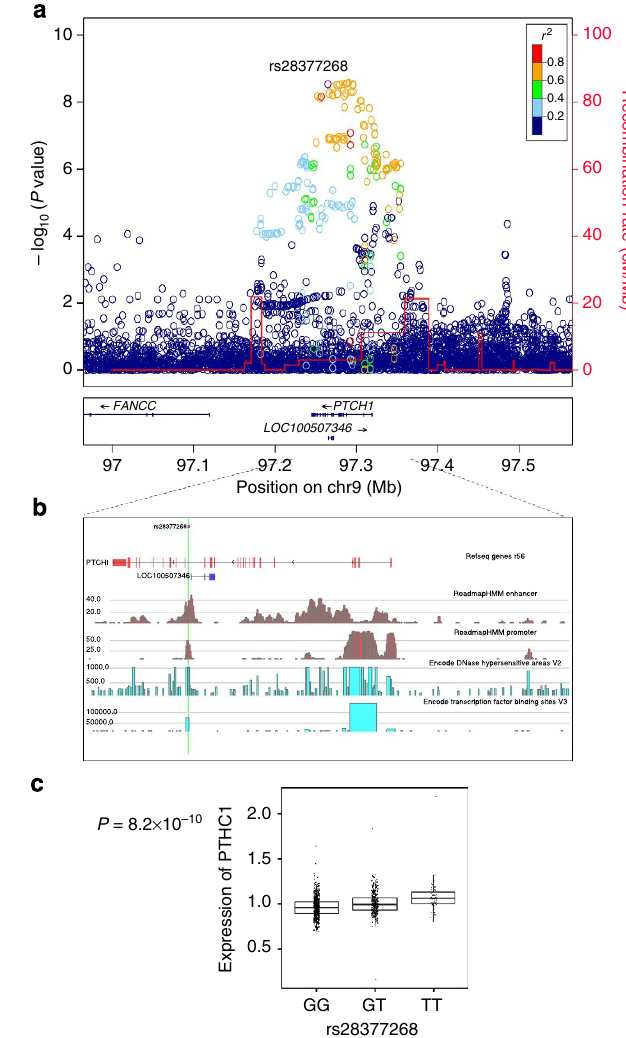
Figure 2 | Regional association plot for the 9q22.23 PTCH1 locus, potential functional elements and genotype-dependent expression. ( a ) Regional association plot for the 9q22.23 PTCH1 locus. P values ( (cid:3) log10) of SNP association with spine BMD in the Icelandic discovery samples are plotted against their positions at the 9q22.23 locus. SNPs are coloured to reflect their linkage disequilibrium (LD) with rs28377268 in the data set. The red line indicates recombination rates, based on the Icelandic recombination map for males and females combined 47 , with the peaks indicating recombination hotspots defining LD blocks in Icelanders. Known genes in the region are shown underneath the plot, taken from the UCSC genes track in the UCSC Genome Browser. All positions are in NCBI Build 36 coordinates. The plot was created using a stand-alone version of LocusZoom software 48 . ( b ) Functional annotation of potential functional elements in the region. Transcription factor binding sites and DNase hypersensitive areas from the ENCODE data is shown 43,44 and enhancer and promoter states from the Roadmap consortium 26 . Location of rs28377268 is indicated by a green vertical line. ( c ) Genotype-dependent gene expression or the PTCH1 gene in blood samples. The P value is derived from regression of the MLR on the carrier status of rs28377268, adjusting for age and sex, and differential cell